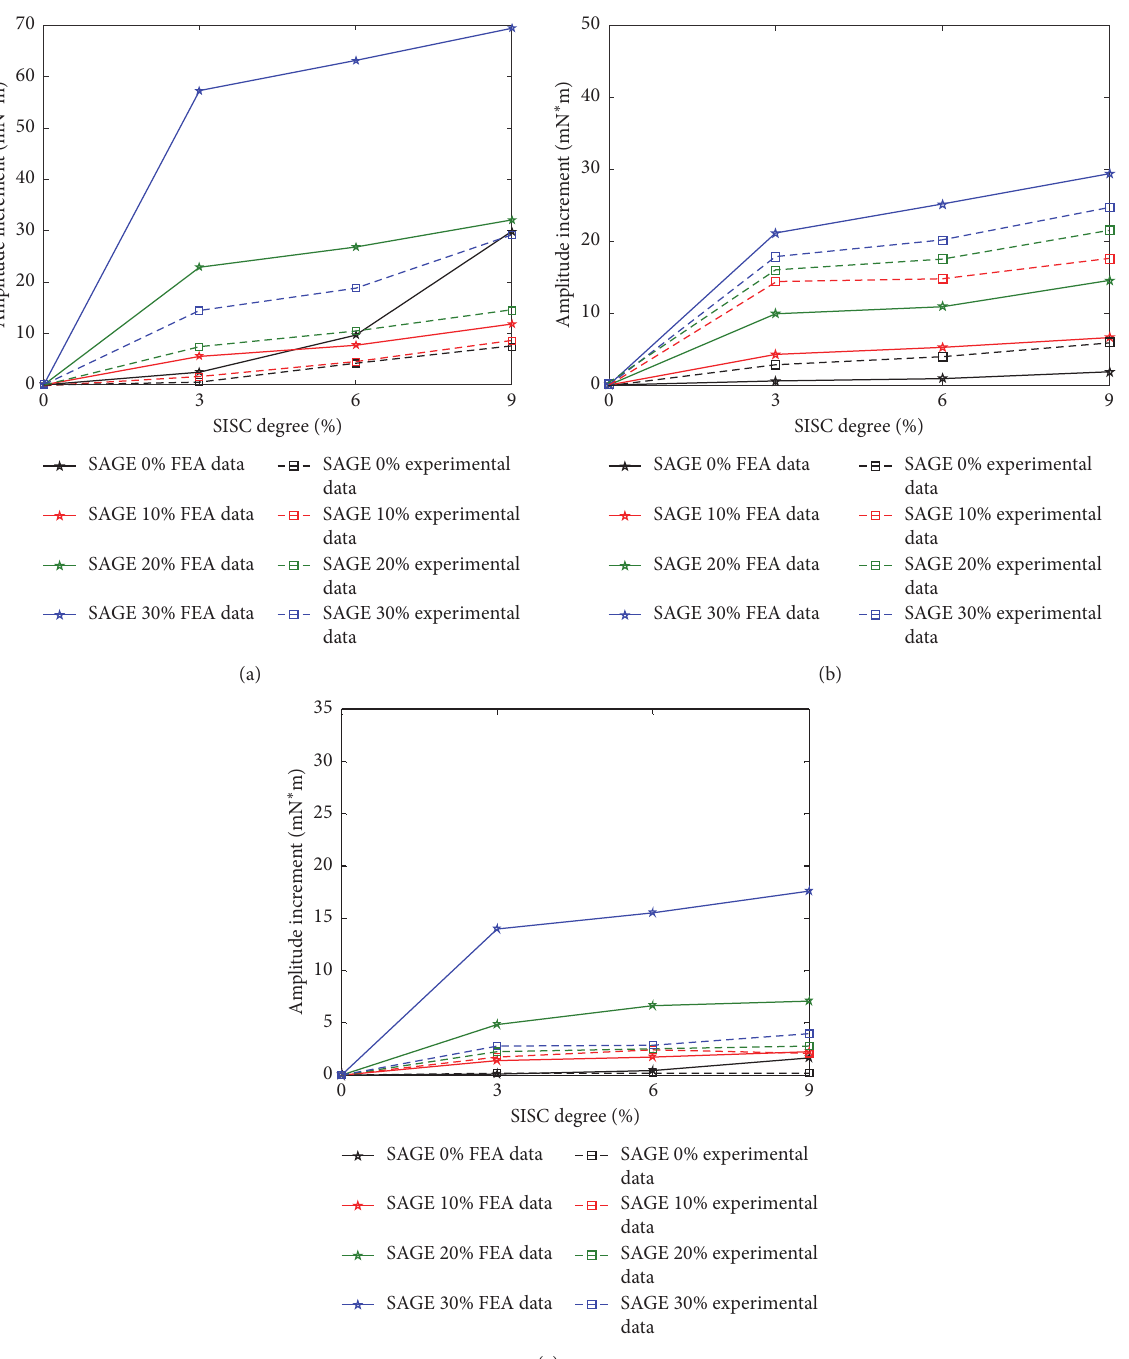
Figure 17: Impact comparison between CF and SISC faults: (a) 2nd harmonic, (b) 4th harmonic, and (c) 6th